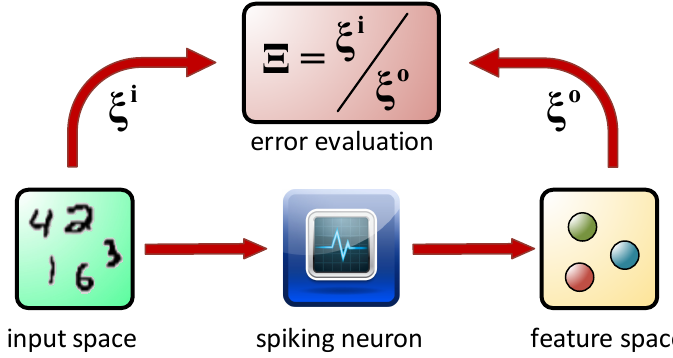
Figure 11. A diagram depicting the data flow and the efficiency evaluation of the unsupervised classification system under consideration.